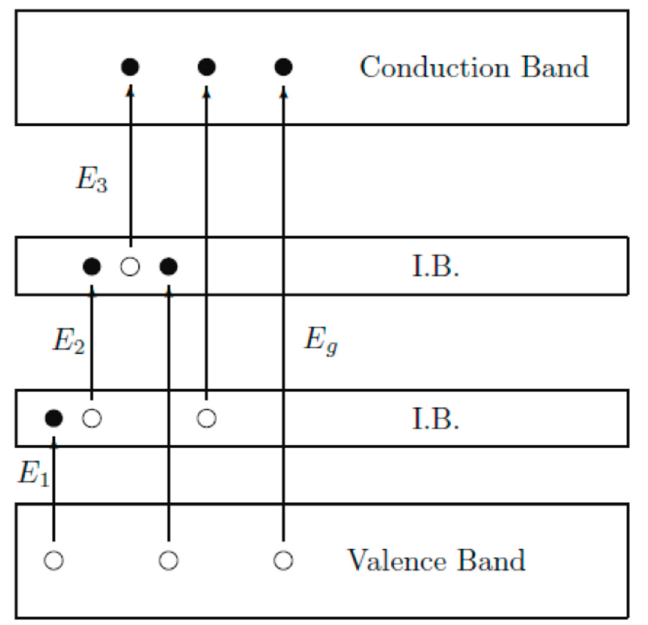
Figure 11. Schematic diagram of energy levels of an IB structure material from Wu and co-works, 2012 [151].